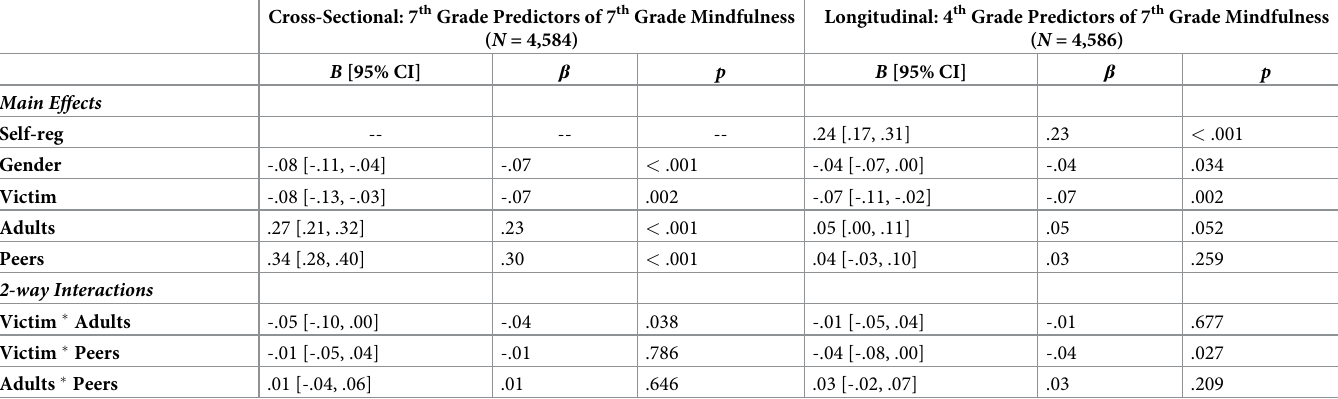
Table 2. Cross-sectional and longitudinal SEM regressing 7th grade mindfulness on social ecology factors. Cross-Sectional: 7 th Grade Predictors of 7 th Grade Mindfulness Longitudinal: 4 th Grade Predictors of 7 th Grade ( N = 4,584)